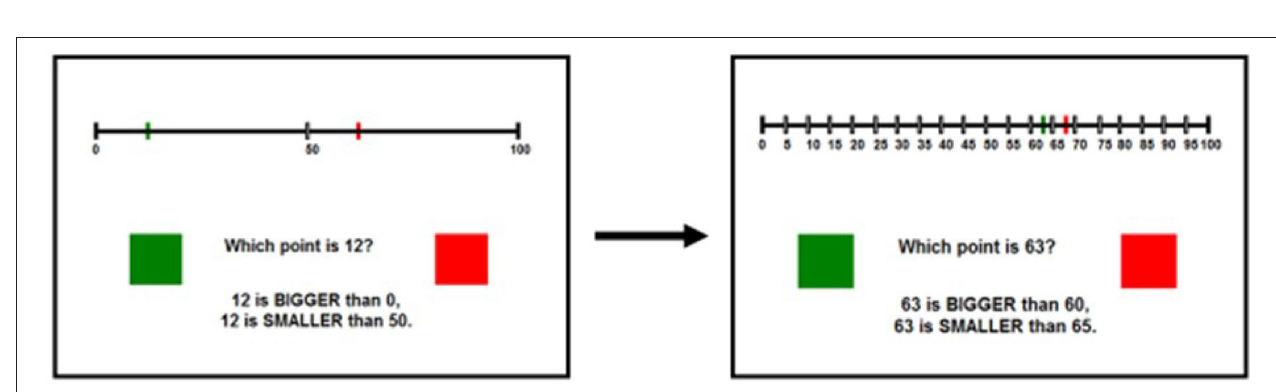
FIGURE 2 | Stimuli for the declarative learning condition. The task follows the same spatial fading as the non-declarative condition but this fading is offset by an increase in available declarative cues.